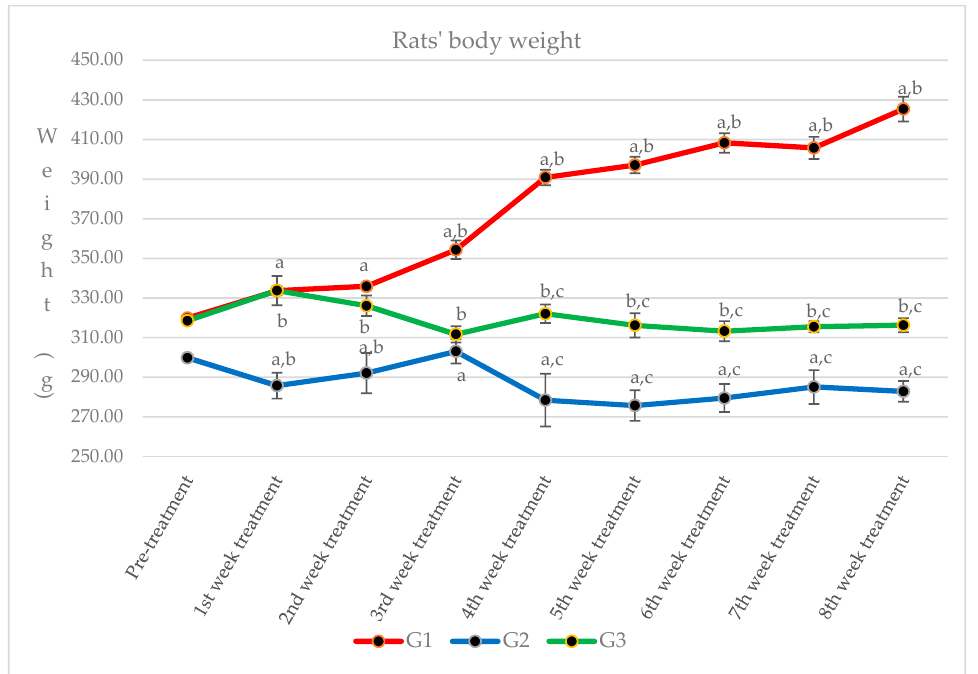
Figure 4. The changes of rats’ body weight in G1: sham-operated control; G2: adrenalectomized (adrx) control given intramuscular dexamethasone (DEX) 120 μ g/kg/day; and G3: adrx and given intramuscular DEX 120 μ g/kg/day and Piper sarmentosum 125 mg/kg/day. Identical letters (a,b,c) indicate significant difference between groups at p < 0.05.